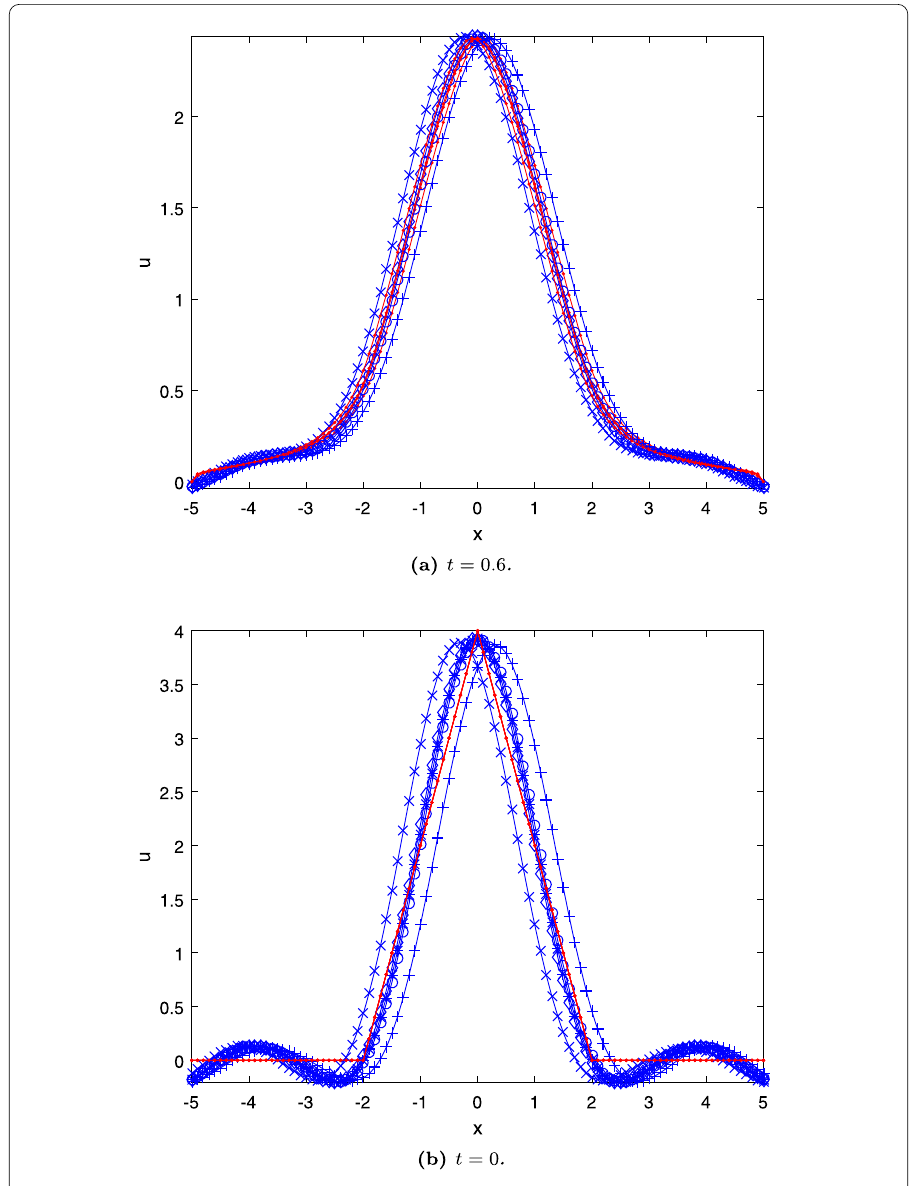
Figure 2 At t = 0.6 and 0, α = 1, s = 2, γ = 0.1, ε = 0.01: Exact and regularized solutions for different θ . Point: exact solution; Star: regularized solution with θ = 0 and μ = 1.8960e–04; Loop: θ = 0.01 and μ = 1.9180e–04; Plus: θ = 0.1 and μ = 2.0983e–04; Diamond: θ = –0.01 and μ = 1.9022e–04; Multiplication: θ = –0.1 and μ = 1.9575e–04